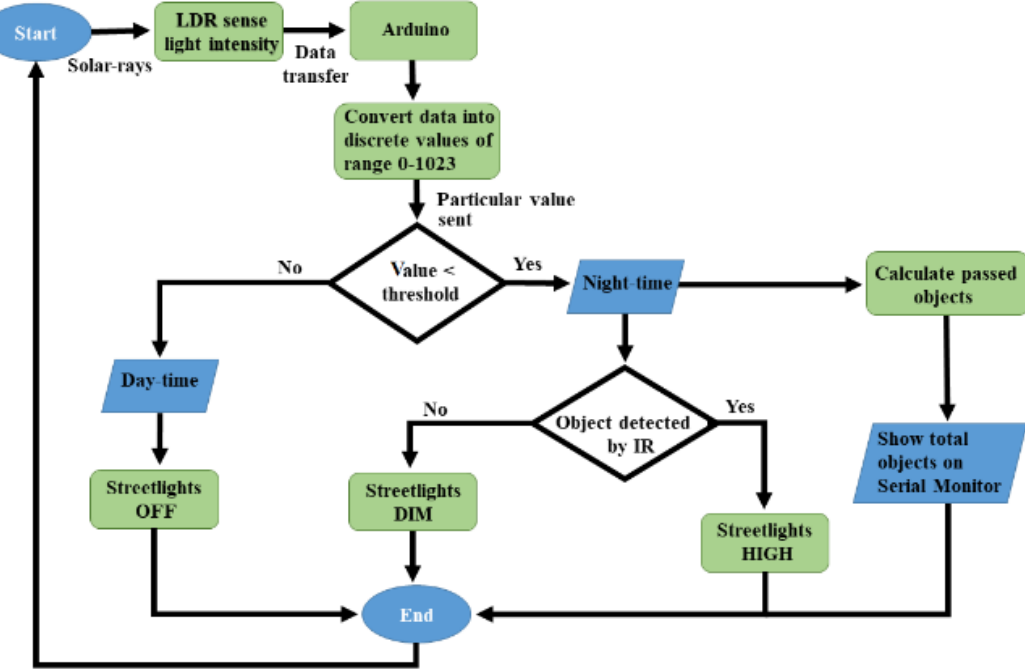
Figure 3. The flow diagram of the automation system based on night-time object detection.